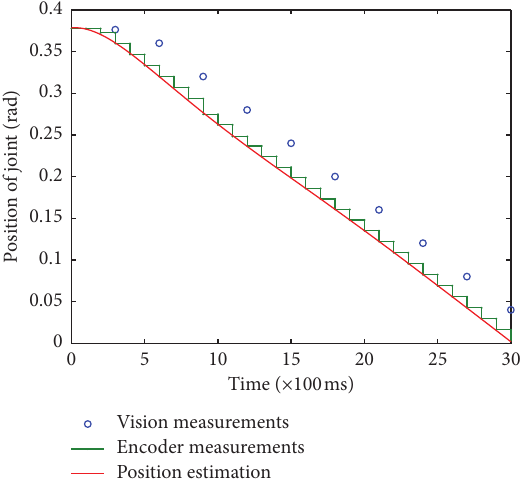
Figure 12: The encoder and visual measurements.